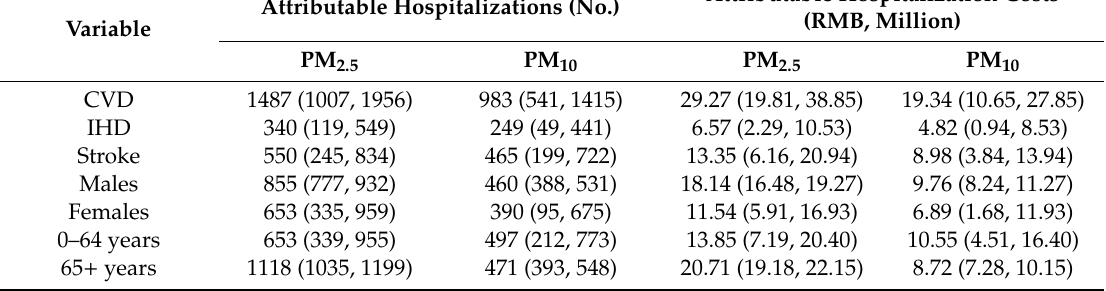
Table 2. The number of hospitalizations and hospitalization costs attributable to PM 2.5 and PM 10 in Wuhan, China, from